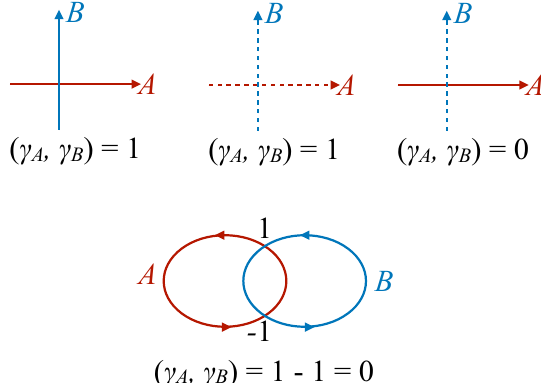
Figure 10 . The definition of intersection number. The solid and dashed lines denote a part of cycle on the first and second Riemann sheet, respectively. If two solid(dashed) lines given by γ A and γ B intersect with each other in respect to a right-handed coordinate, we say ( γ A , γ B ) = +1. If the intersection is given by lines on different sheets from each other, we say ( γ A , γ B ) = 0. For example, two cycles not crossing branch-cuts always give ( γ A , γ B ) =